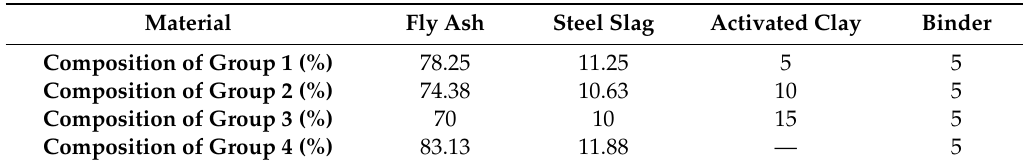
Table 3. Percentage composition of substrate and binder in Residue and Soil Phosphorus Removal Composite (RSPRC) in four groups.